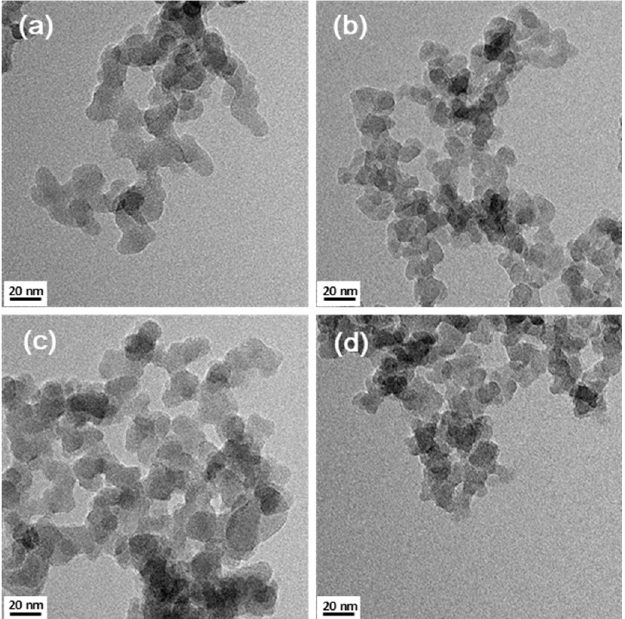
Figure 4. Transmission electron microscopy (TEM) images of ( a ) FS-polydimethylsiloxane (PDMS), ( b ) Hydrophilic fumed silica (FS-OH), ( c ) GPS-modified silica nanoparticles (FS-EP) and ( d ) APS-modified silica nanoparticles (FS-NH) (100,000× magnification).